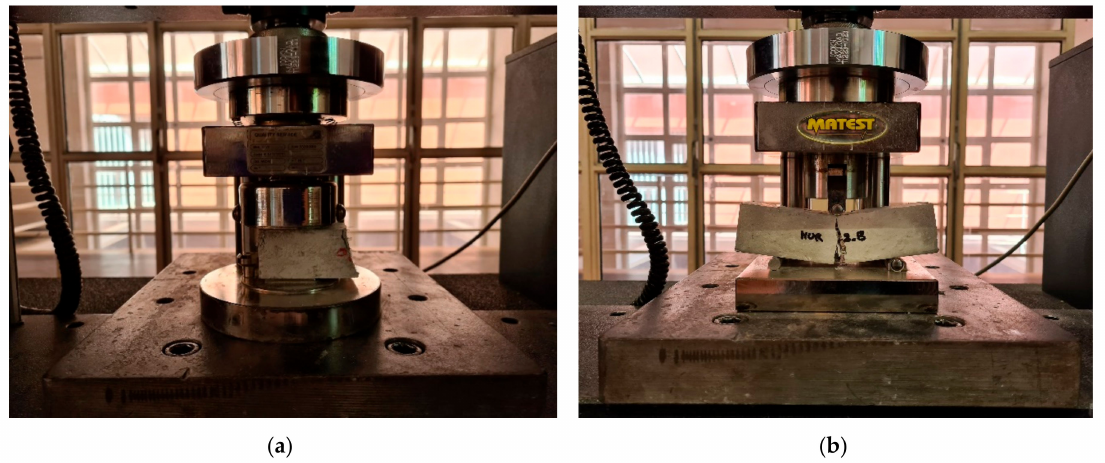
Figure 3. Test setup: ( a ) compression and ( b ) flexural test on the